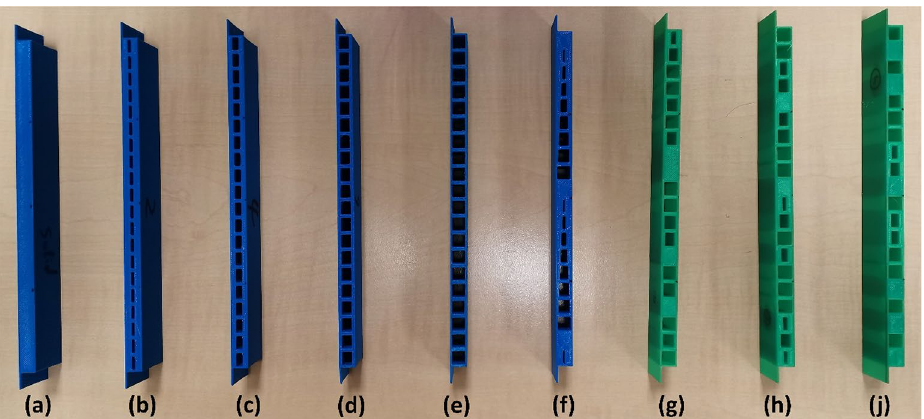
Figure 19. 3D printed samples ( a ) low bound 20 voxels single void beam; ( b – e ) 20 voxels single void beam with 20% 40% 60% and 80% void respectively; ( f ) 20 voxels single void beam with incremental void sizes; ( g – j ) optimised 20 voxels single symmetric void beam for TSE1- TSE3. (Image is based on the photograph taken by the